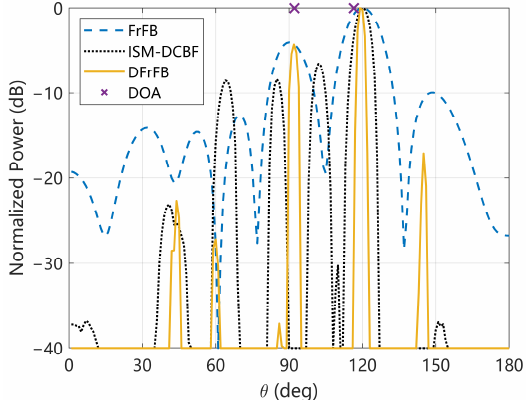
Figure 7. The spatial spectrum of a one-frame LFM signal received in the experiment.